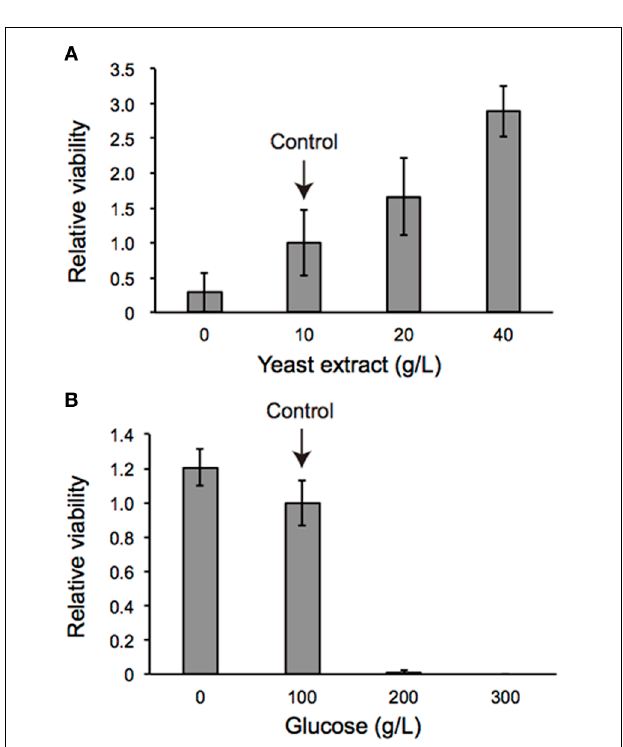
FIGURE 8 | Viability of dilp2 -overexpressing flies depends on nutritional conditions. Dilp2 -overexpressing flies ( sd > dilp2 ) were reared on media supplemented with various concentrations of yeast extract (A) or glucose (B) . Relative viability of the dilp2 -overexpressing flies ( sd > dilp2 ) for each medium was calculated based on the number of control siblings.